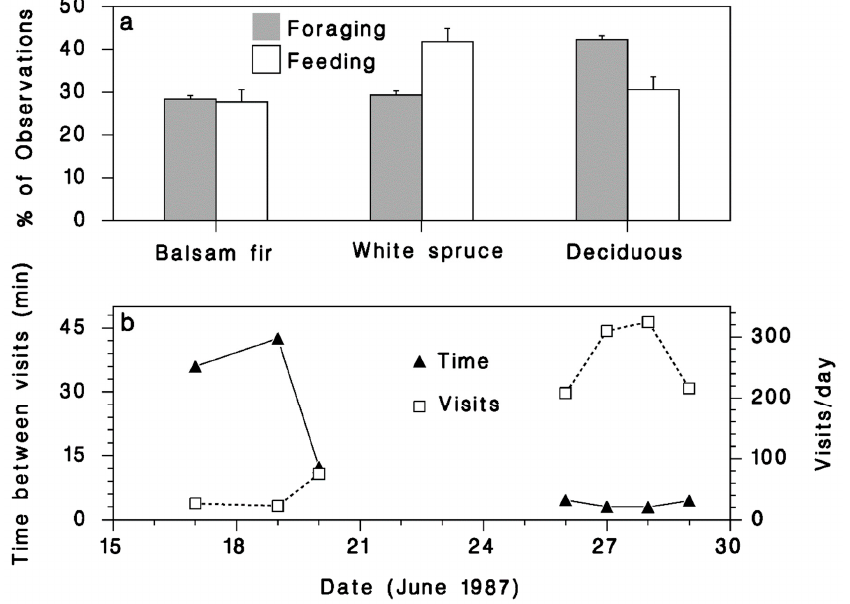
Figure 9. ( a ) Relative frequency of foraging (grey bars) and feeding (open bars) observations recorded on various tree